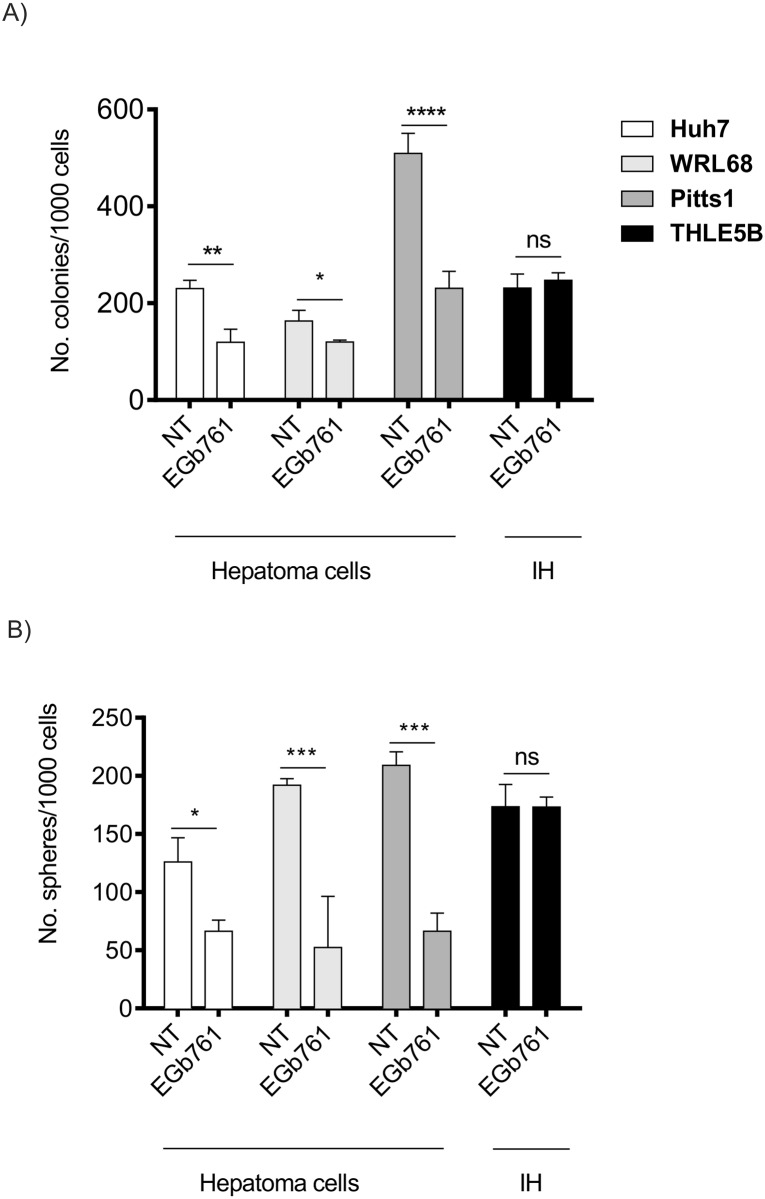
EGb761 reduces colony and sphere forming potential of hepatoma cells.(A) Colony and (B) sphere frequencies after three-day exposure to EGb761. Graphs represent the number of colonies/spheres / 1000 plated cells. The data are means ±SD of three independent experiments; *p<0.05, **p<0.01, ***p<0.001, ****p<0.0001, analyzed by student’s t-test.